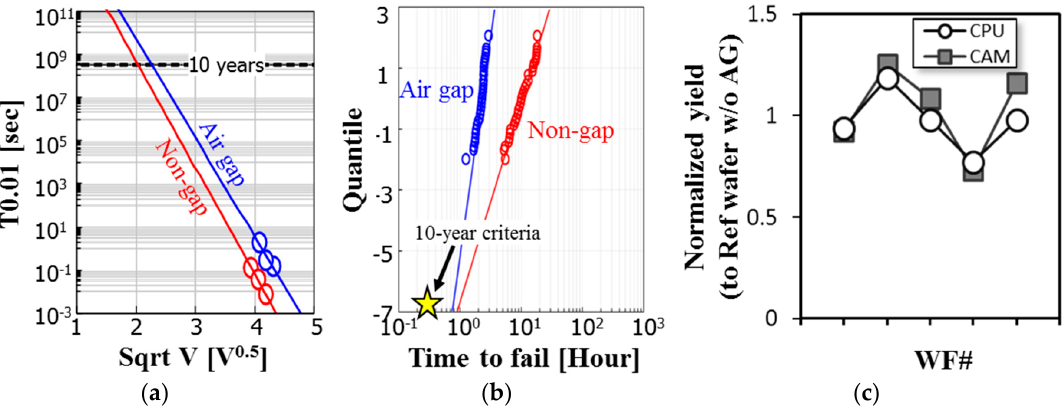
Figure 11. Results of the reliability test with and without the AG for the ( a ) TDDB and ( b ) EM. ( c ) Yields of logic blocks with AG, normalized with respect to those of non-AG wafers.